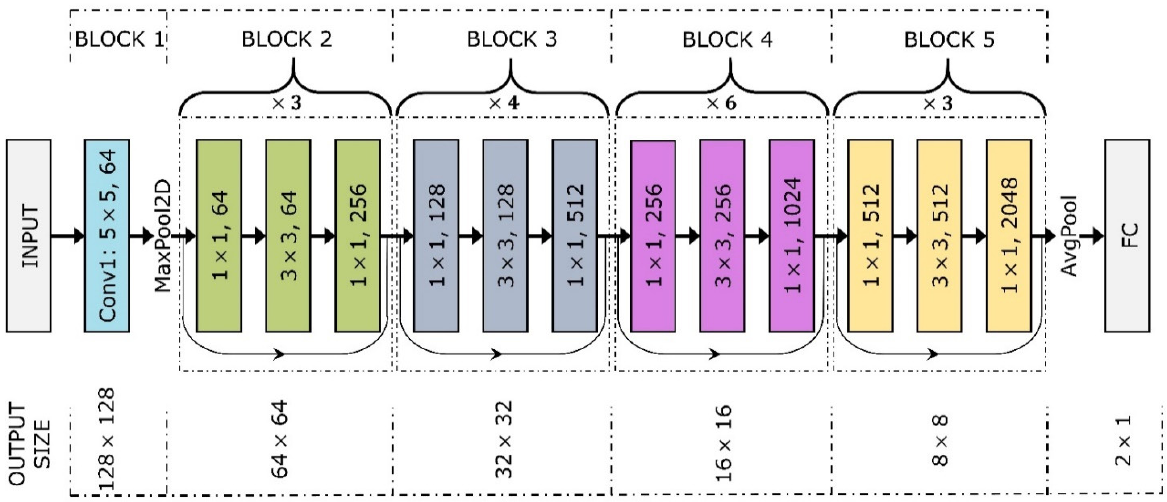
Figure 6. The architecture of the 50-layer deep neural network used in this study. Abbreviations: Conv—convolutional layer, MaxPool2D—two-dimensional maximum pooling layer, AvgPool— global average pooling layer, FC—fully connected layer. Table 2. Details of the 50-layer deep residual neural network used in this study. Abbreviations: